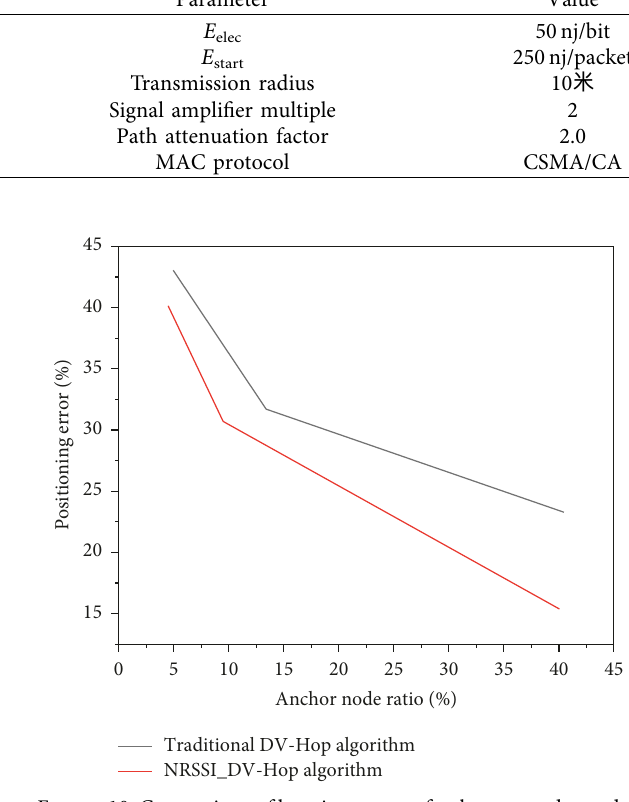
Figure 10: Comparison of location errors of unknown nodes under multiple hops.